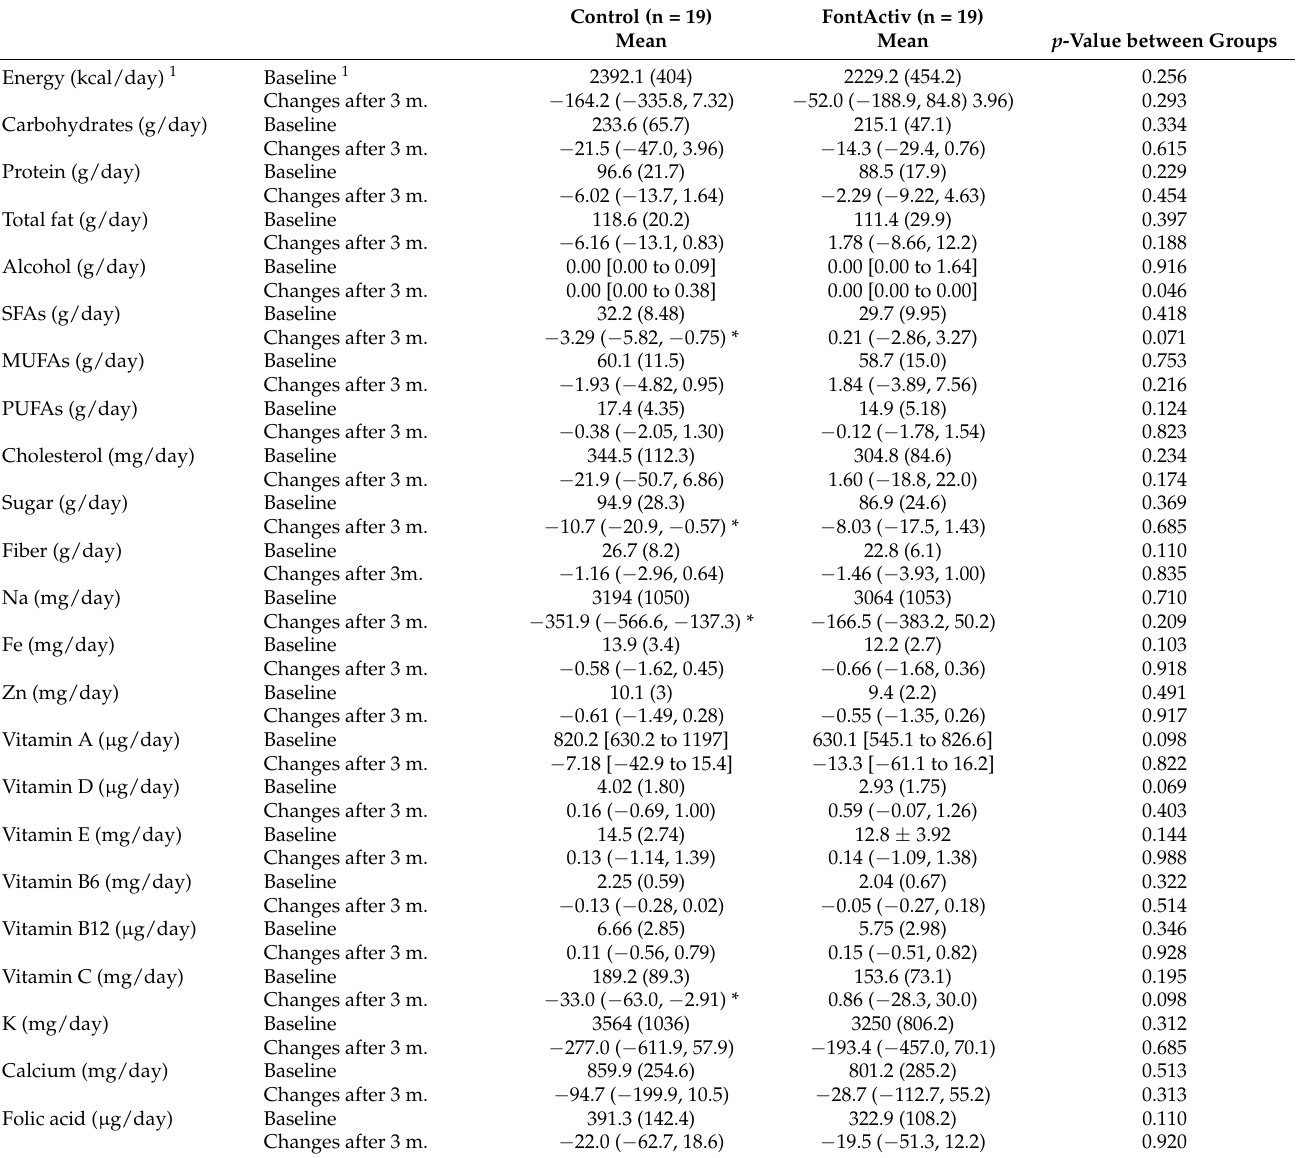
Table 2. Dietary intake changes (excluding the Oral Supplement) in CKD participants according to the intervention arm after 3 months of